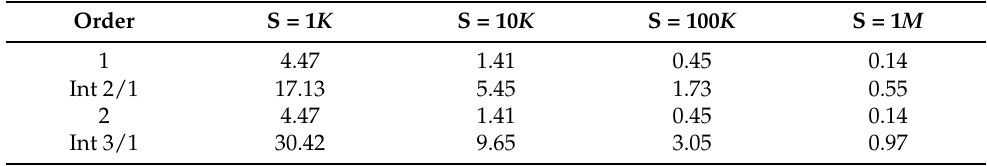
Figure 6. Here the variance decomposition of the pre-catXL total annual aggregate loss variance is displayed. The largest contribution comes from the marginal contribution of the order M = 1 occurrence loss, followed by the 2/1 interaction term, the marginal order 2 term, and the 3/1 interaction term. Table 4. Convergence errors (in percentage terms) associated with the marginal and interaction terms for the pre-catXL total variance. Column 1 indicates the term (which is 1 for the M = 1 marginal contribution, and Int 2/1 for the interaction term between M = 1 and M = 2). Similar to Table 2, results for S = 1 K to S = 1 M years of simulation are